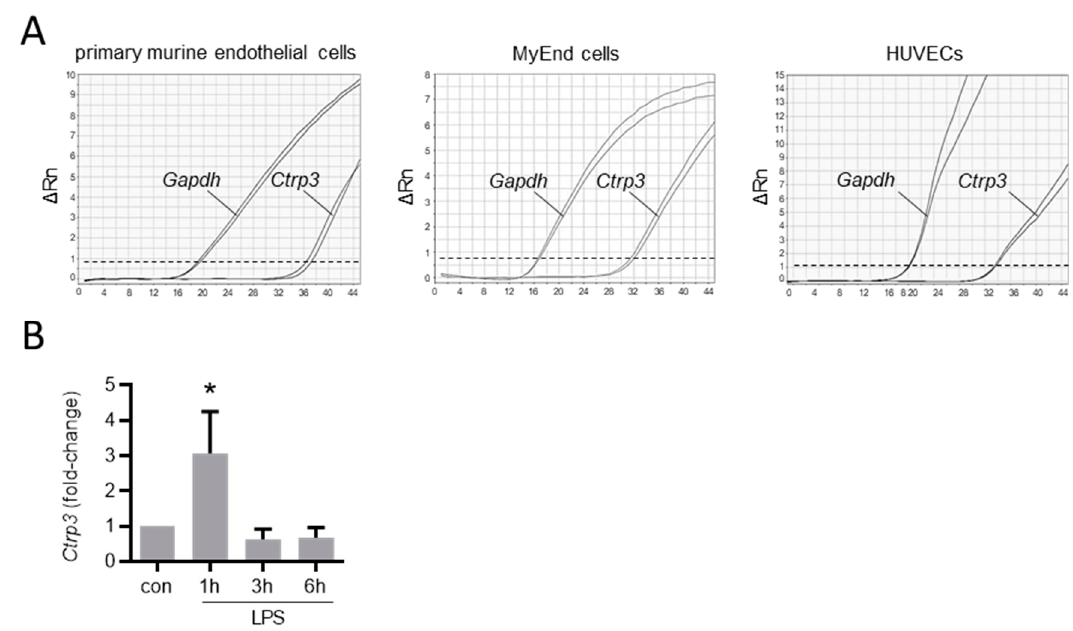
Figure 2. Ctrp3 expression in endothelial cells. ( A ) The Ctrp3 (C1q/TNF-related protein 3) mRNA expression in primary murine endothelial cells, in murine MyEnd (myocardial endothelial) cells, and HUVECs (human umbilical vein endothelial cells) was analyzed by real-time PCR. Gene expression of Gapdh (glyceraldehyde-3-phosphate dehydrogenase) is shown as a housekeeping gene control. Representative pictures are shown. Dashed line indicates threshold line. Rn = normalized reporter. ( B ) MyEnd cells were stimulated with LPS (lipopolysaccharides, 50 ng/mL) for the indicated period and Ctrp3 mRNA levels were analyzed by real-time PCR. * p < 0.05 vs. con = unstimulated control, n = 5–9.